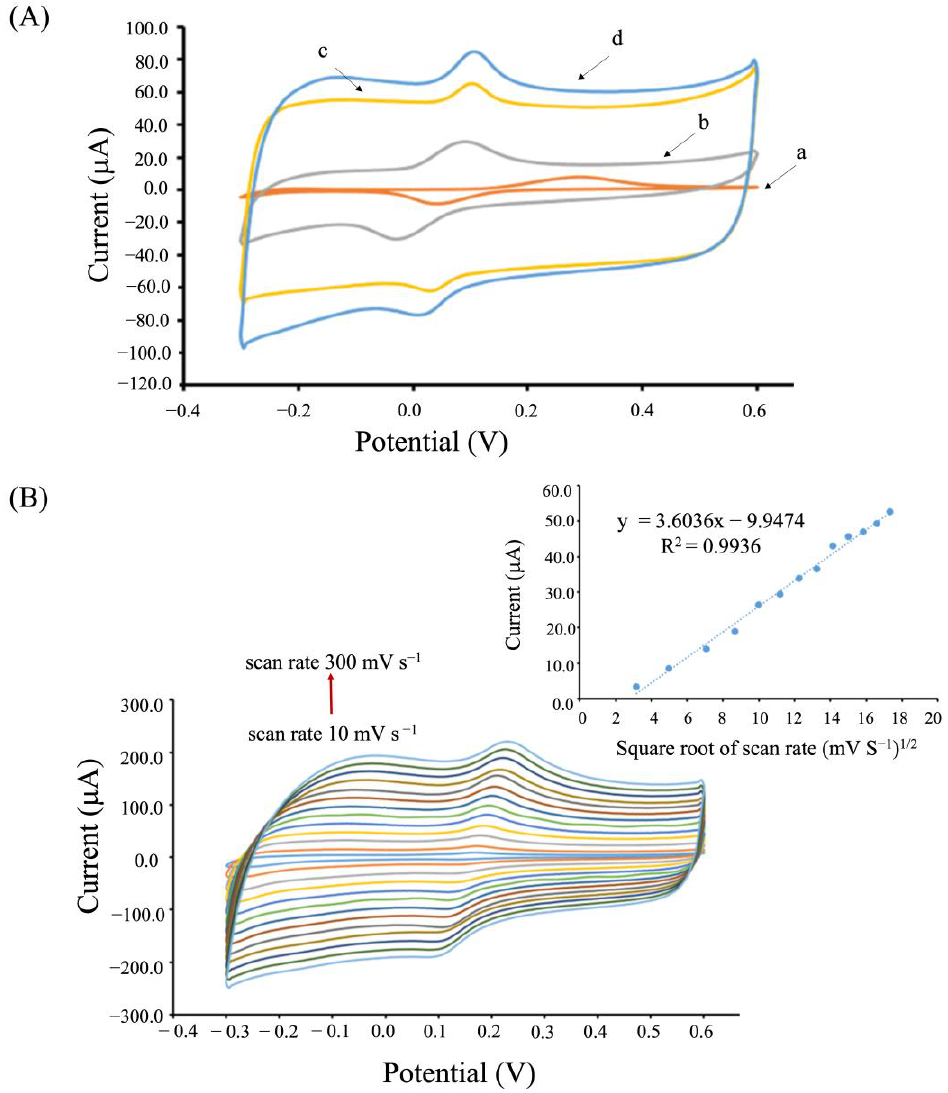
Figure 3. ( A ) Cyclic voltammograms (CVs) of SPCE (a), OMC / SPCE (b), PEDOT - PSS / SPCE (c), and OMC - PEDOT - PSS / SPCE (d) in 100 μ mol L −1 DA in 0.10 mol L −1 PBS (pH 7.4) at a scan rate of 0.050 V s −1 . ( B ) CVs of DA responses for OMC - PEDOT - PSS / SPCE in 100 μ mol L −1 DA at different scan rates from 10 to 300 mV s −1 , and the inset showing the plot between the oxidation peak currents and the square root of the scan rate.